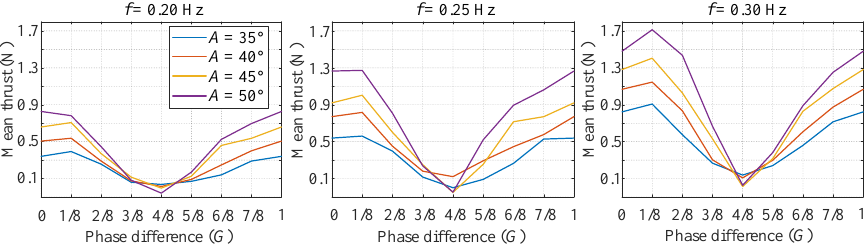
Figure 5. Experimental results of sinusoidal-based mode.